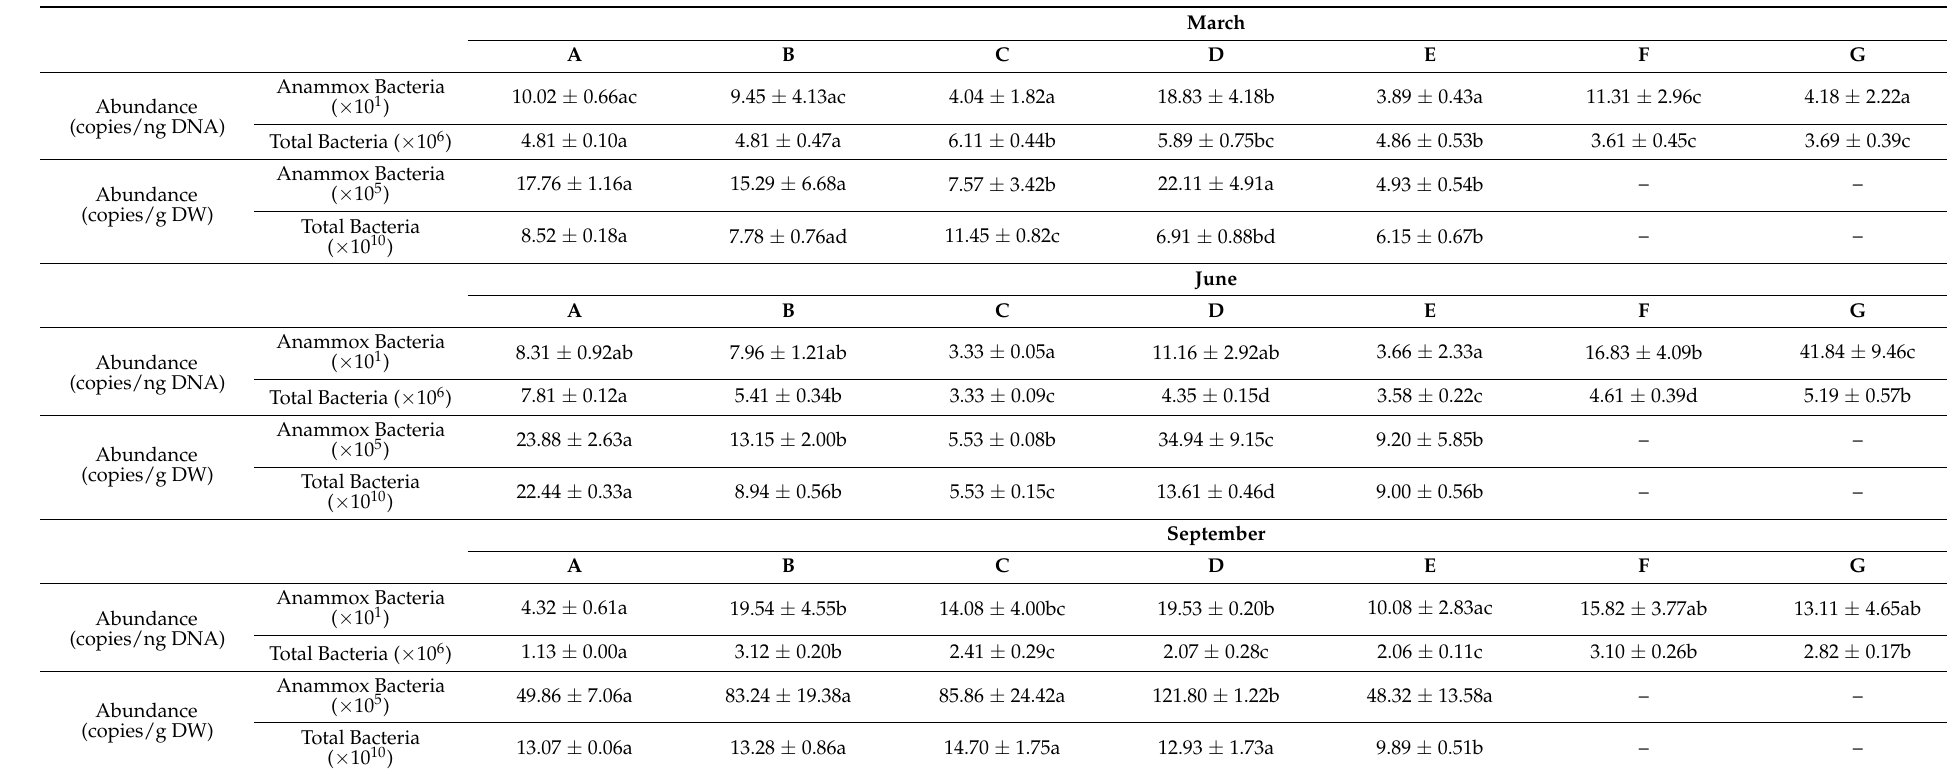
Table 4. Quantification of anammox and total bacterial 16S rRNA gene copies in the